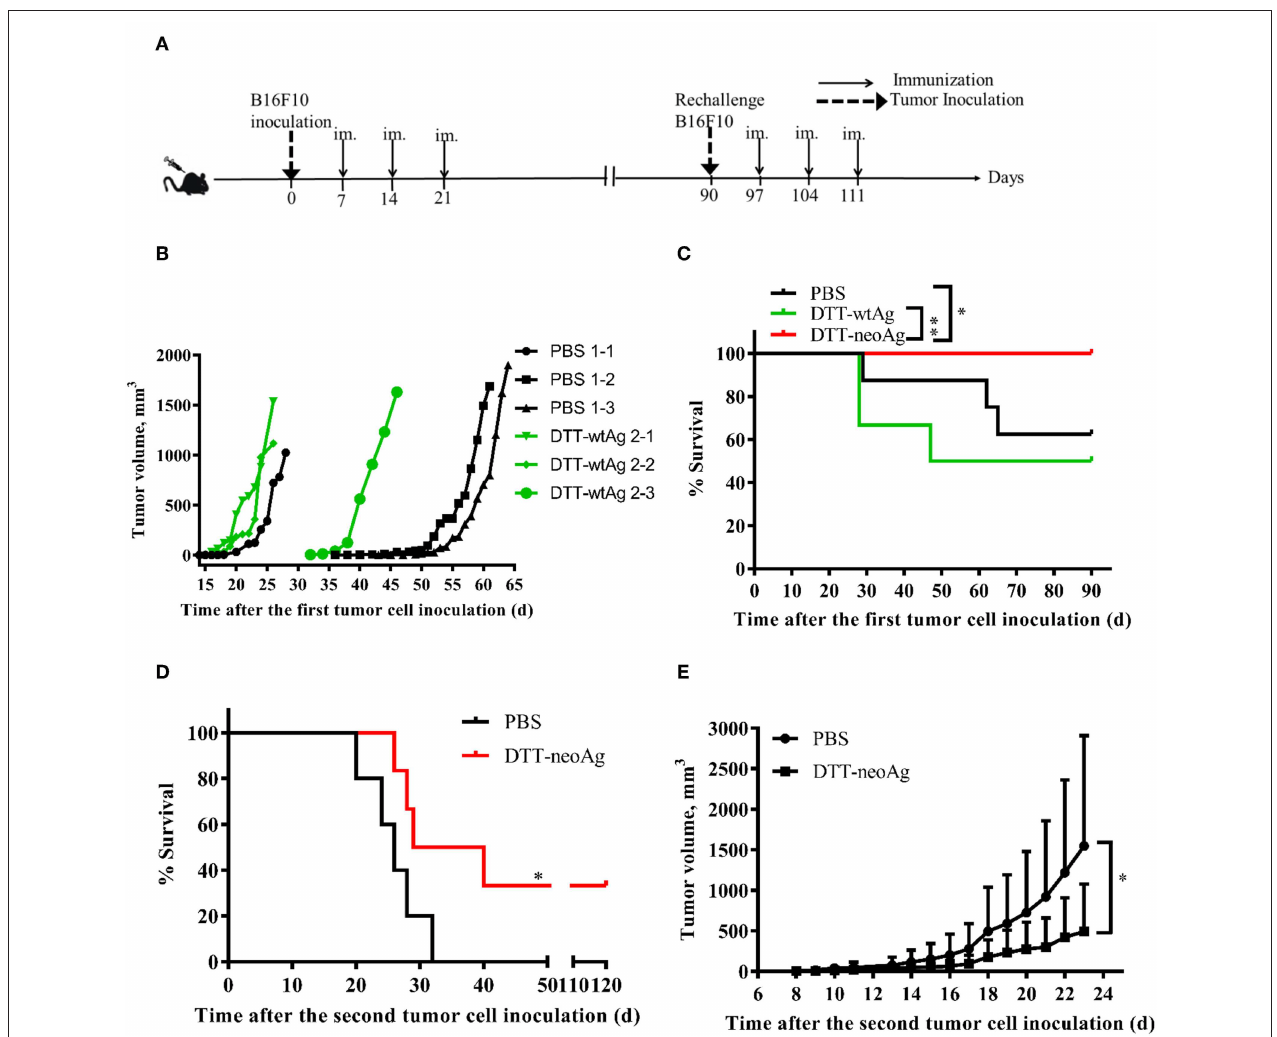
FIGURE 4 | Anti-tumor effects of DTT-neoAg vaccination in the therapeutic mouse melanoma model. The data are means ± SEM, **** P < 0.0001; *** P < 0.001; ** P < 0.01; * P < 0.05, Student’s T-test. (A) The treatment schedule. (B,C) C57BL/6 mice ( n = 6–13) were s.c. administered with 2.5 × 10 4 B16F10 cells into the right flank of the mice. Seven days after challenge, mice were immunized with DTT-neoAg, DTT-wtAg, or PBS formulated with Alum + CpG three times at 1-week intervals. (B) The tumor growth curves for individual mouse. Green line: DTT-wtAg-treated mice, and black line: PBS-treated mice. (C) The Kaplan-Meier survival plot. The statistical significance was determined by Log-rank test. * P < 0.05. (D,E) On day 90, the tumor-free mice in PBS-treated group and neoAg-treated group were re-challenged with 7.5 × 10 4 B16F10 cells in the left flank. One week after the re-challenge, mice were immunized with PBS or neoAg formulated with Alum + CpG for 3 times at weekly intervals. (D) The Kaplan-Meier survival plot. The statistical significance was determined by Log-rank test. * P < 0.05. (E) The tumor growth curves.